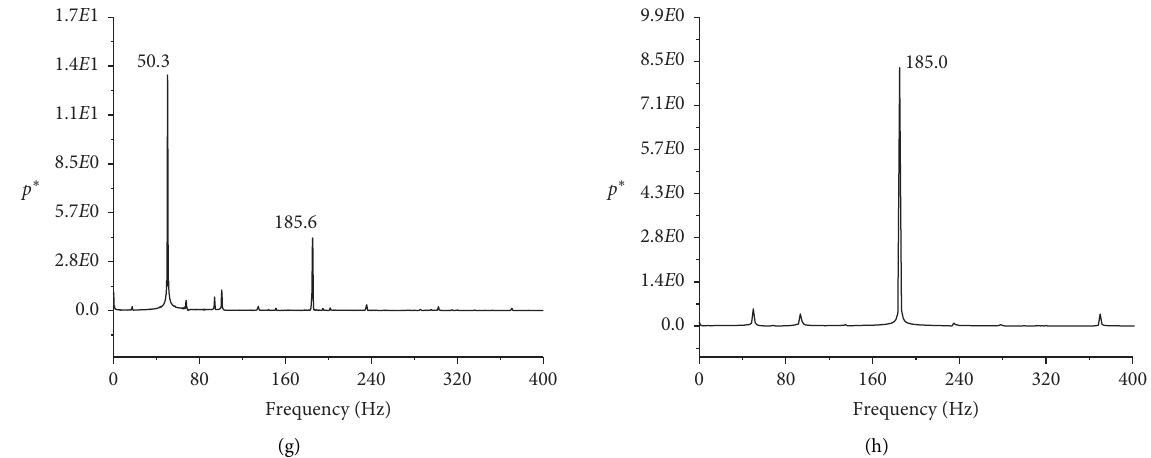
Figure 7: Pressure fluctuation FFT analysis: (a) v � 10 m/s, (b) v � 15 m/s, (c) v � 20m/s, (d) v � 30m/s, (e) v � 40m/s, (f) v � 50m/s, (g) v � 60m/s, and (h) v � 70m/s.